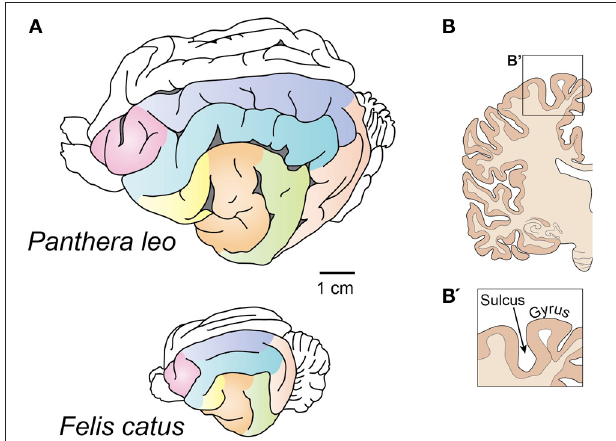
FIGURE 1 | Gyrencephalic brains. (A) Brains of the lion (top) and the house cat (bottom). Despite a different level of gyrification, note the similarities in the pattern of gyri and sulci distribution. After Welker (1990). Homologous gyri are colored to facilitate comparison. (B) A coronal section of the human brain showing gryi and sulci. This image does not follow the scale bar in (A)